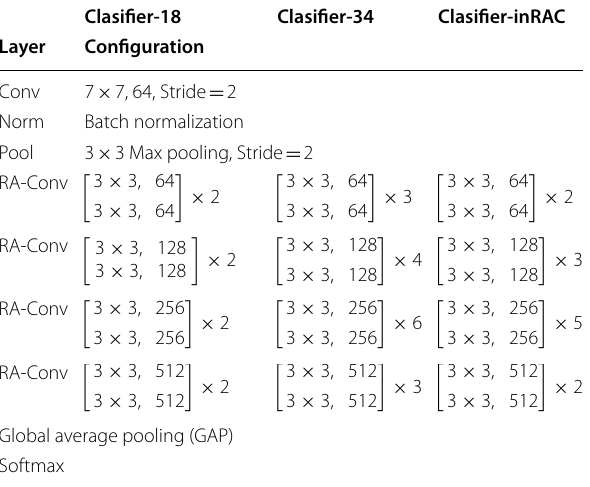
Table 7 Overview of classifiers with similar structure but different depth from Classifer-inRAC